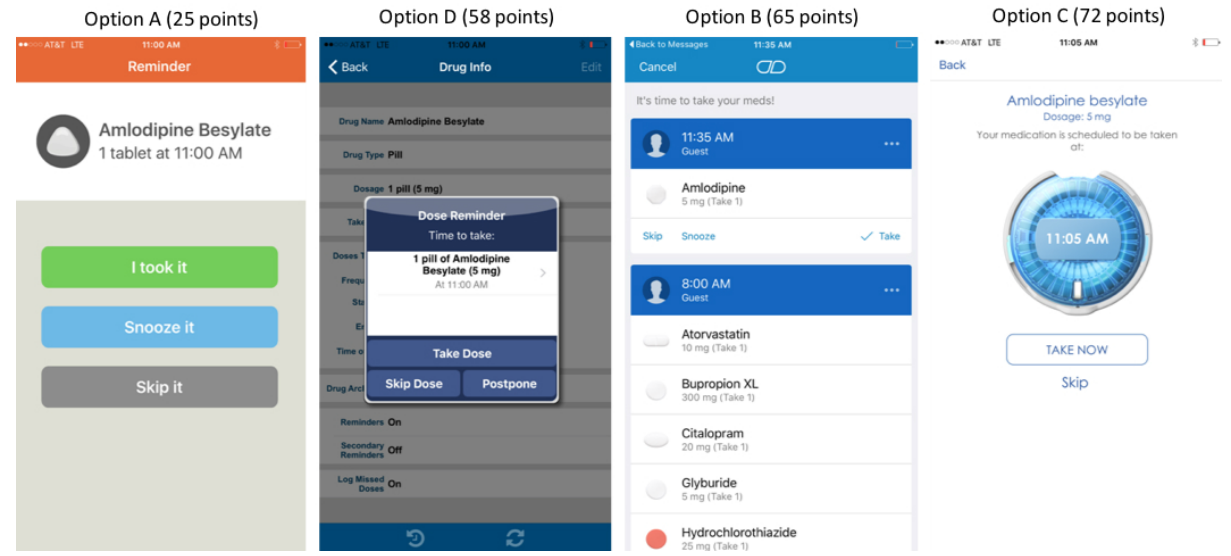
Figure 3. Medication reminder screenshots ranked from most preferred (lower score) to least preferred (higher score) based on design and visual appeal and respective scaled scores.